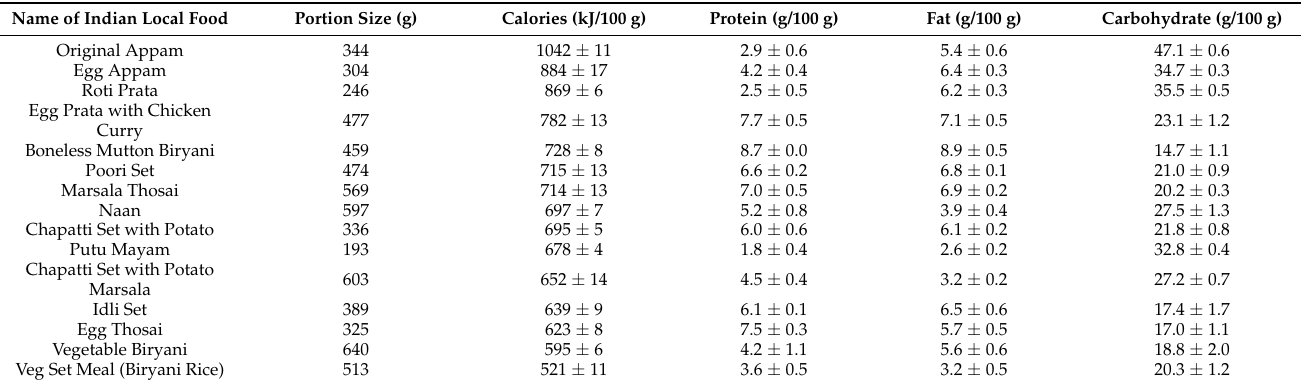
Table 3. Energy and macronutrient content of the commonly consumed Indian